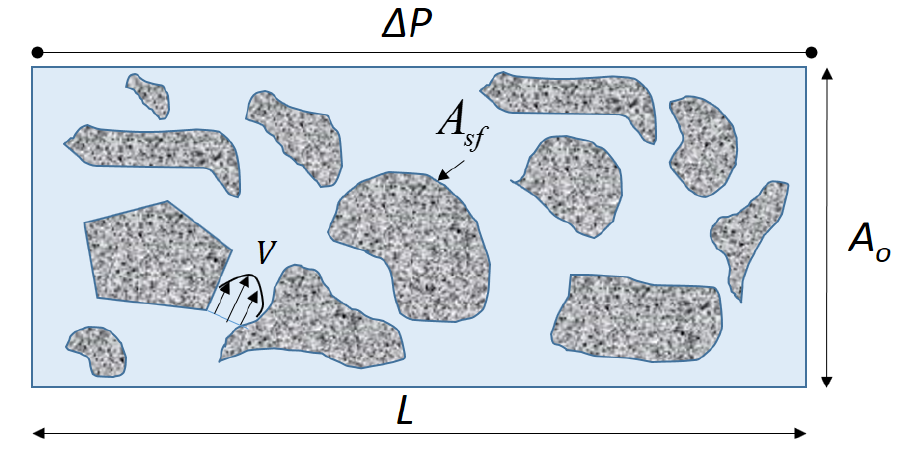
Figure 3. Pore-scale mesh generated from the digital image of the rock.